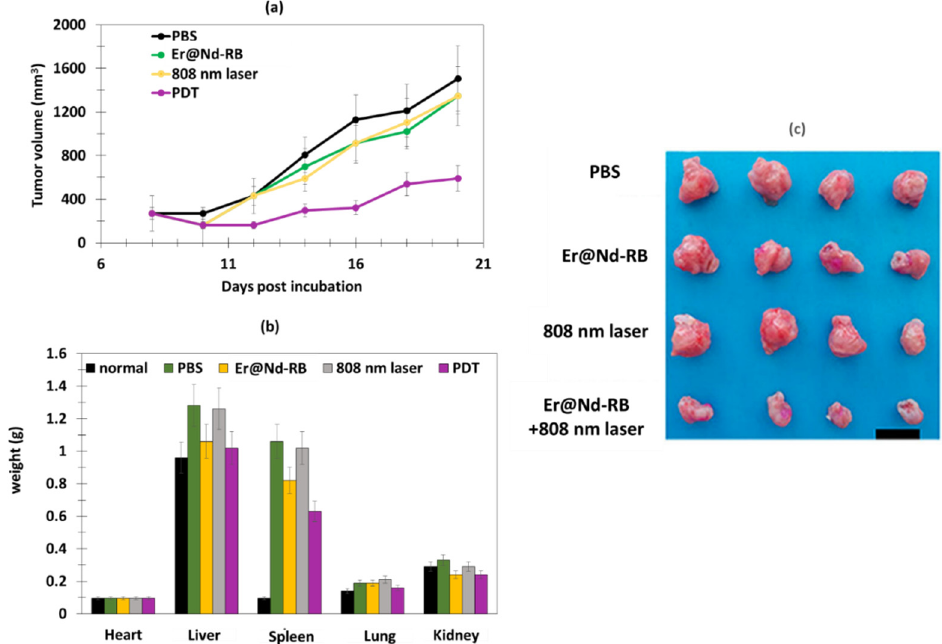
Figure 8. PDT on 4T1 breast murine tumor after in vivo experiment (808 nm, 520 mW/cm 2 ). ( a ) Tumor volume growth as a function of number of days of treatment, and ( b ) weight of heart, liver, spleen, lung and kidney for the four mice groups. ( c ) Digital photos of tumors for the four groups of mice. The mice were sacrified 14 days after treatment (808 nm, 520 mW/cm 2 ). Figures ( a , b ) adapted from Li et al. [25]. Figure ( c ) reprinted with permission from Li et al. [25]. Copyright 2016 American Chemical Society.